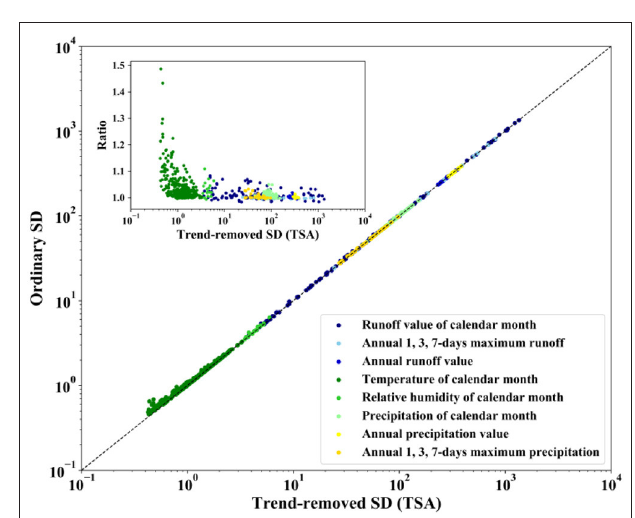
FIGURE 4 | Comparison of ordinary SD and trend-removed